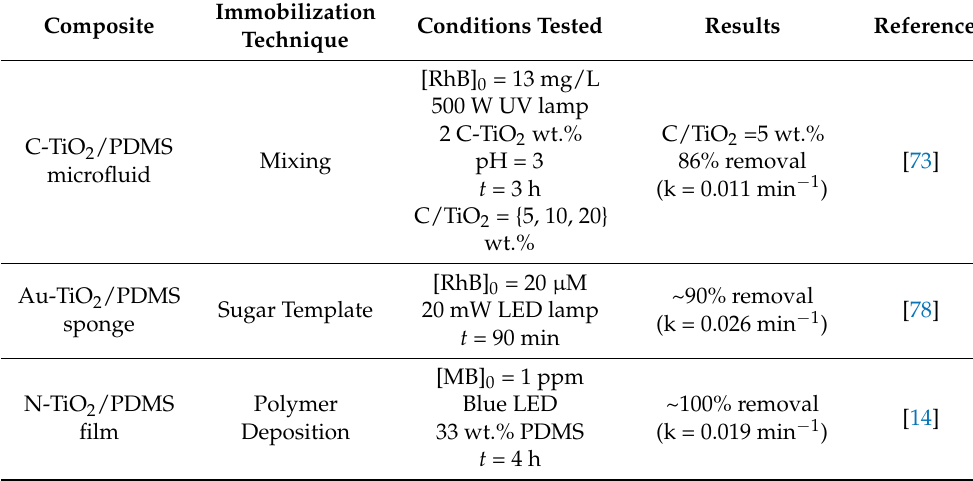
Table 15. Catalyst doping effect on the PDMS-supported photocatalysis